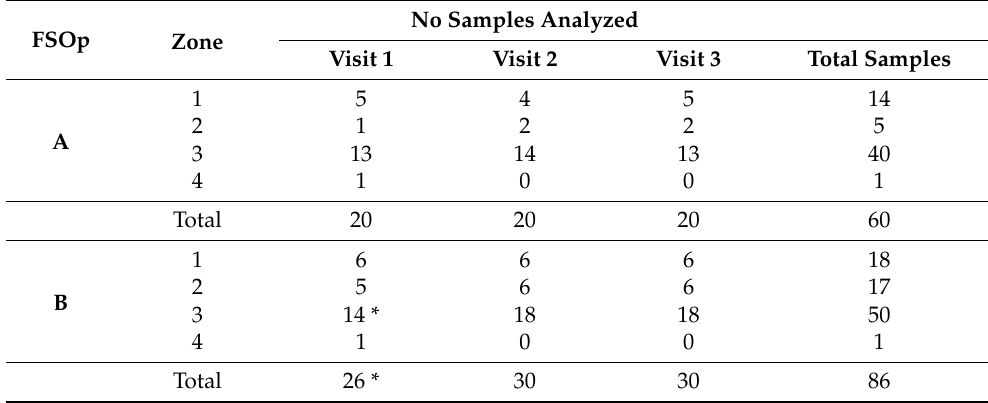
Table 1. The number of surface samples collected for each zone in both FSOp.